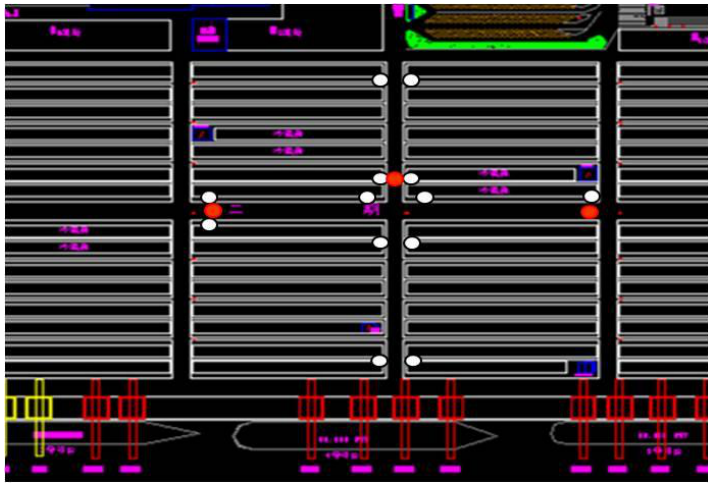
Figure 18. Location of tags in validation experiment